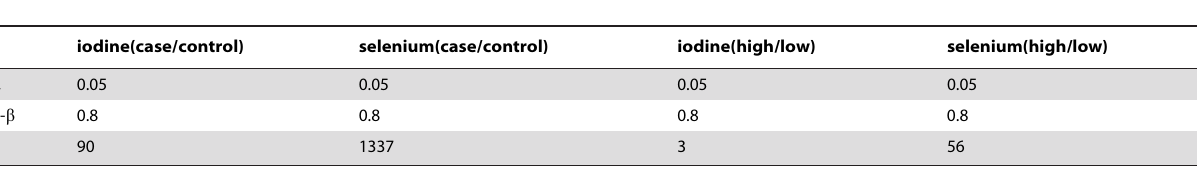
Table 7. Statistical Power Calculations for a Paired t Test and Their Effect on Desired Sample Size.